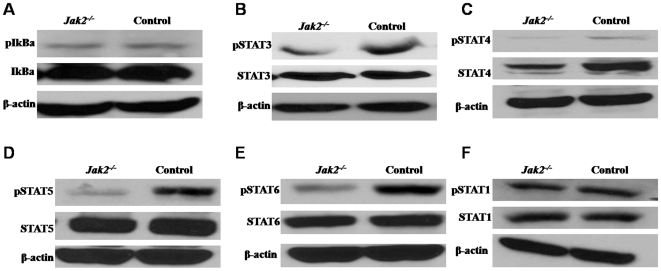
Western blot analysis of the activation states of Jak2 downstream molecules.2×106/ml Jak2−/− and control BMDCs were harvested after 30 min of LPS stimulation (1 µg LPS/ml) and cell lysates were prepared for Western blot analysis of the phosphorylated form of signaling molecules. (A) pIκBα; (B) phosphorylated STAT3 (pSTAT3); (C) pSTAT4; (D) pSTAT5; (E) pSTAT6; and (F) pSTAT1. Four independent experiments were performed and consistent results were obtained.